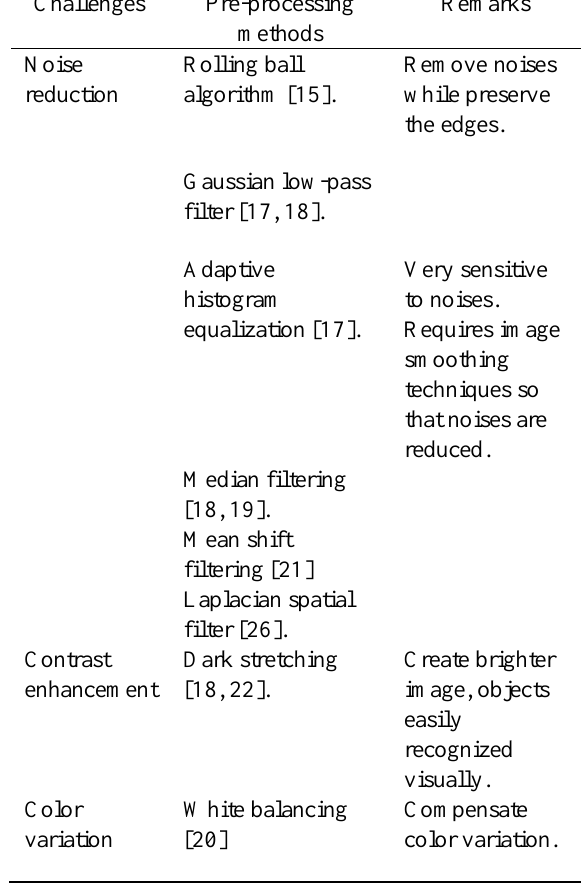
Table 1. Summary of pre-processing techniques